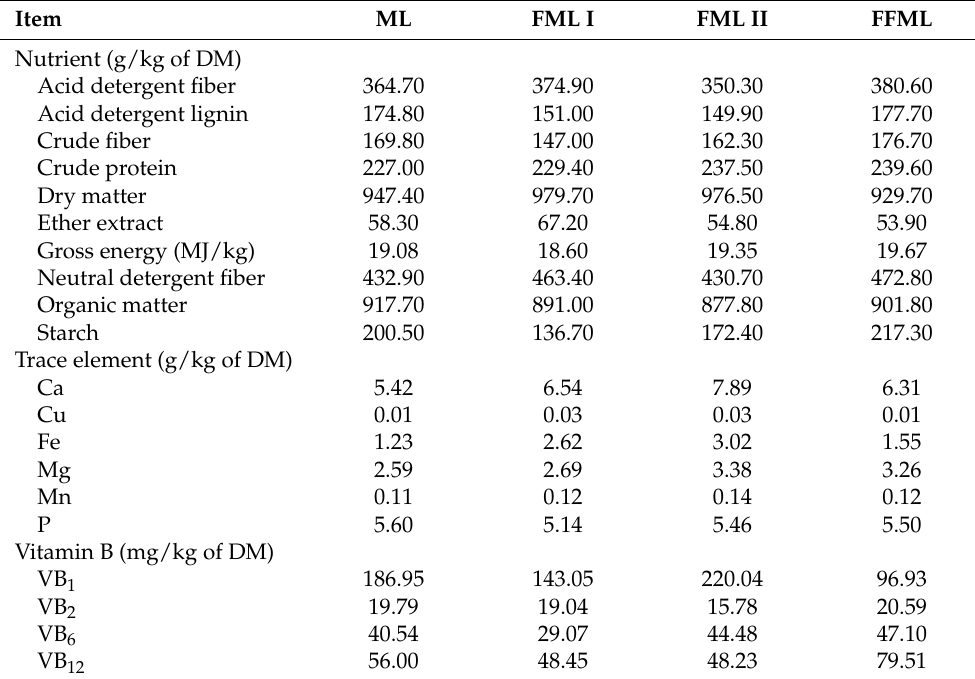
Table 1. Nutritional composition of Mao-tai lees and fermented Mao-tai